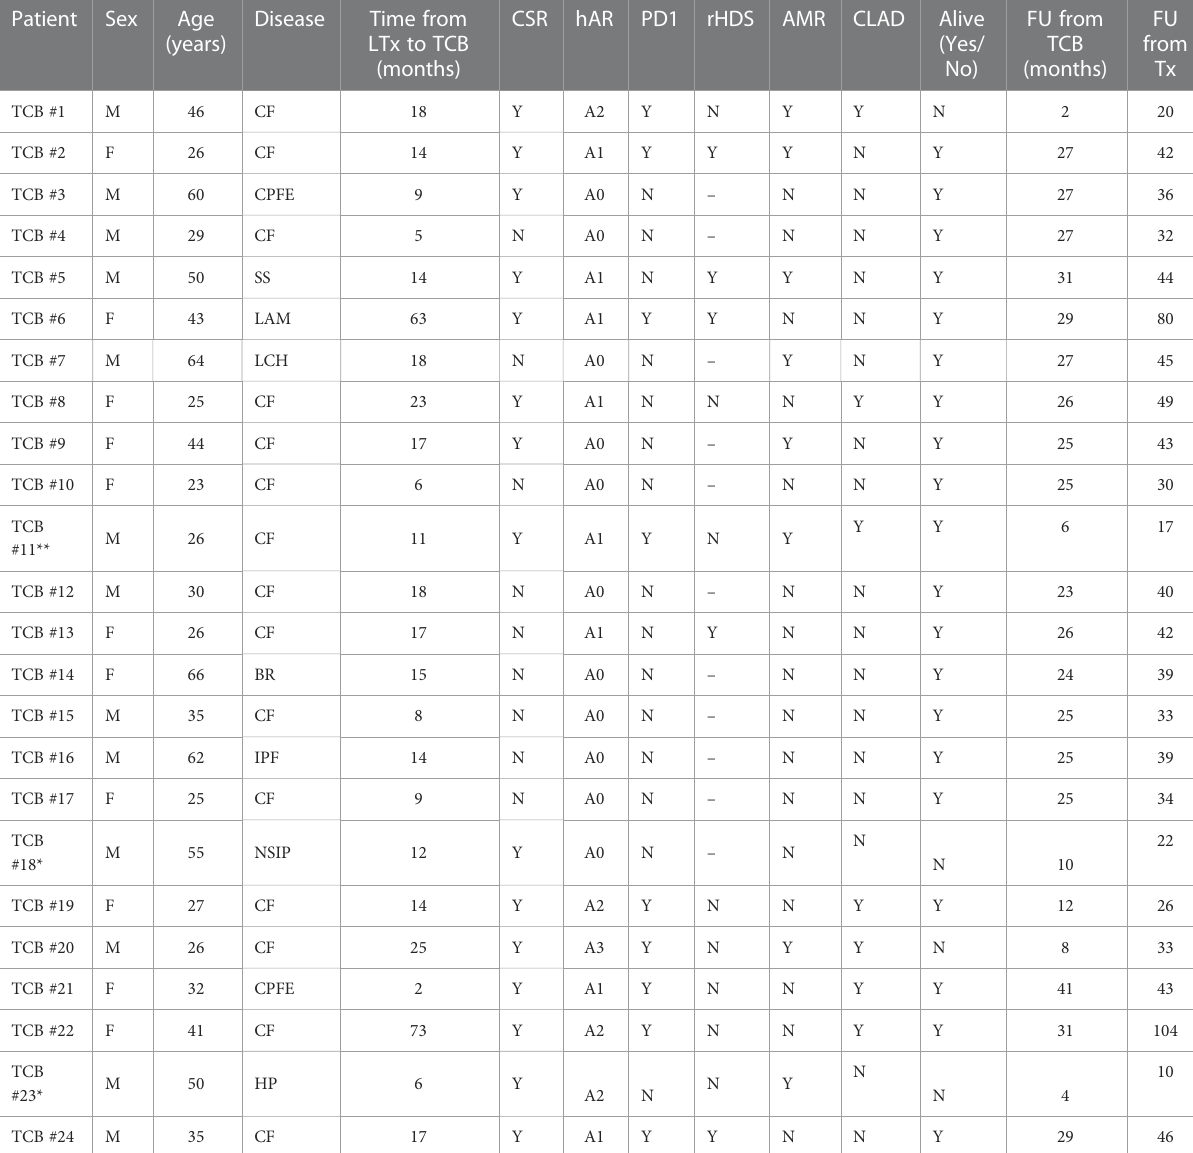
TABLE 1 Clinical characteristics of patients who underwent transbronchial cryobiopsy.